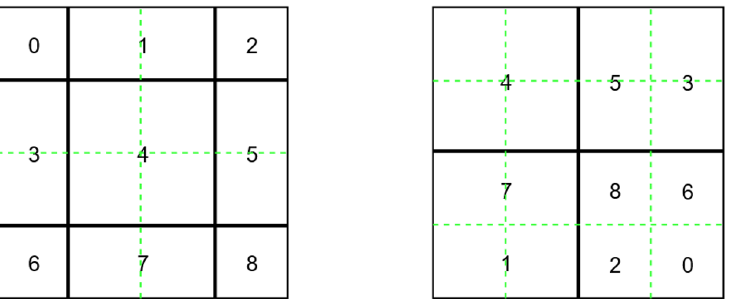
Figure 3. Illustration of window division and Mask token labeling of a small piece of data before and after window shifts. The left picture is a schematic diagram before the window shifts, and the right picture is a schematic diagram after the window